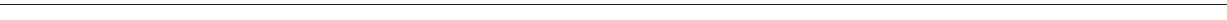
FIGURE 4 | and deviant stimulus (lower panel), for each neuron. Blue, green, and red dots represent the neurons that were localized to the ventral ( n = 12), dorsal ( n = 24), and medial ( n = 9) subdivisions of the MGB, respectively ( n = 45, neurons that were localized to one of the three MGB subdivision). Gray dots represent MGB neurons that were not localized to a specific MGB subdivisions ( n = 3). In both plots, positive values (above the horizontal line at the origin) indicate a reduction in firing rate with cortical deactivation (neurons receive facilitatory cortical influences), whereas negative values (bellow the horizontal line) indicate an increment in firing rate with cortical deactivation (neurons receive suppressive influences from the cortex). The difference in firing rate was inversely correlated with CSI for both standard and deviant stimuli. The slopes of the standard and deviant regression lines are not significantly different from each other [ANCOVA: main effect of stimuli, F (1,92) = 1.89, p = 0.172; main effect of CSI, F (1,92) = 43.27, p = 0; interaction, F (1,92) = 0.23, p = 0.634; n = 48], indicating that the correlation coefficients between standard and deviant are not different. The AC differentially affects the discharge rate of neurons depending on their SSA level. Neurons without SSA are mainly facilitated, whereas some neurons with high SSA are suppressed by the cortex. AC, auditory cortex; MGB, medial geniculate body; MGV, ventral subdivision of the MGB; MGD, dorsal subdivision of the MGB; MGM, medial subdivision of the MGB; SSA, stimulus specific adaptation; CSI, common SSA index; Adapted from Antunes and Malmierca